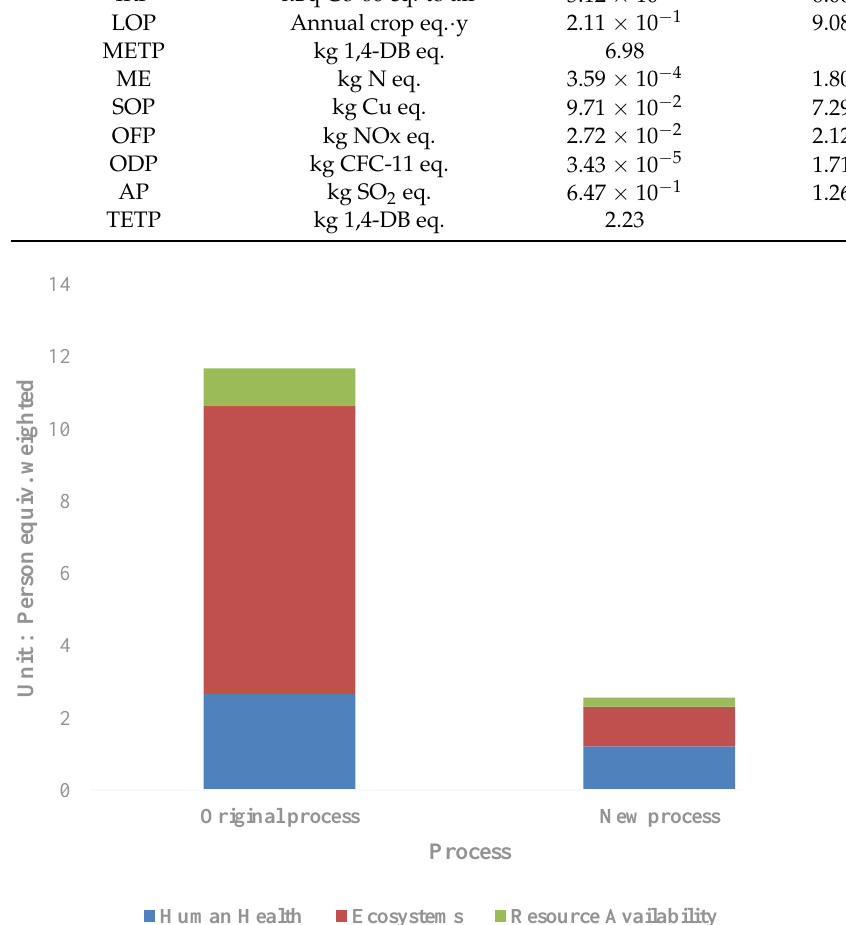
Figure 3. Comparison of the life cycle impact indicators of the silver separation processes.